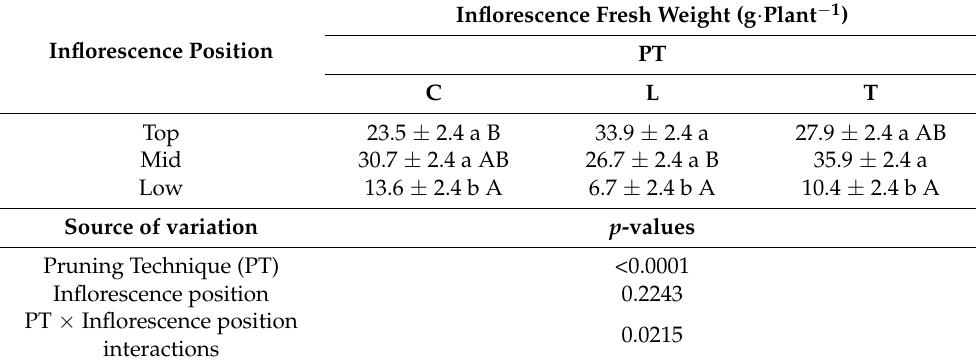
Table 4. Least square means ( ± standard error) of inflorescence fresh weight (g · plant − 1 ) and weight fraction for each pruning technique (PT) for the third harvest time (9 weeks of flowering). Means for each PT (lowercase letters, in columns) and for each inflorescence position (uppercase letters, in rows) with at least one identical letter are not significantly different from each other according to Fisher ´ s LSD test with α = 0.05. Pruning techniques (C—control; L—lollipop; T—topping). Note that p -values correspond to F-test within an ANOVA.